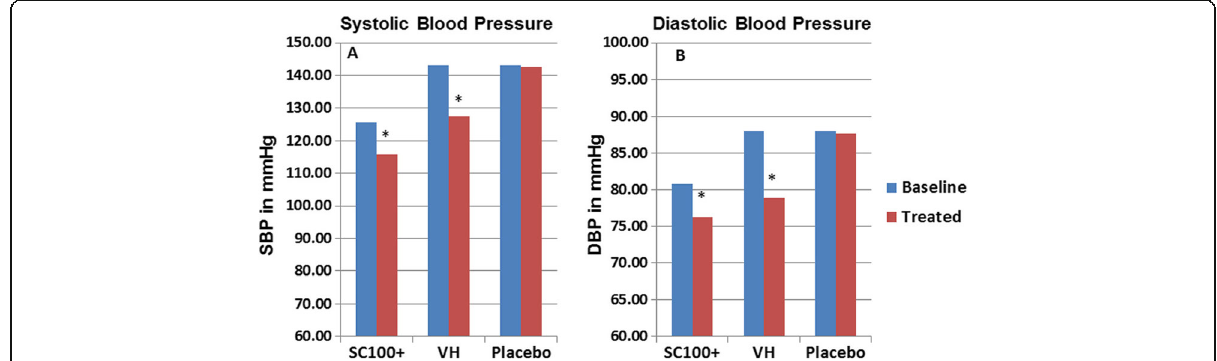
Fig. 2 SC100+ lowers systolic and diastolic blood pressure. Subjects took open-labeled SC100+ for 15 weeks. Systolic Blood Pressure (SBP in A) and Diastolic Blood Pressure (DBP in B) were measured at baseline (blue bars) and after taking SC100+ (red bars). SBP and DBP were in the normal range before and after SC100+. All significant reductions ( p <0.05 in paired t tests) in SBP and DBP are designated with a Star. For comparison with hypertensive patients on drugs, the VH (80 mg valsartan +12.5 mg hydrochlorothiazide) and Placebo samples were from a published multicenter, double blind, randomized trial [69] on 132 hypertensive patients (average age of 59 years and 59% male with starting BP of 143/88 mmHg) treated